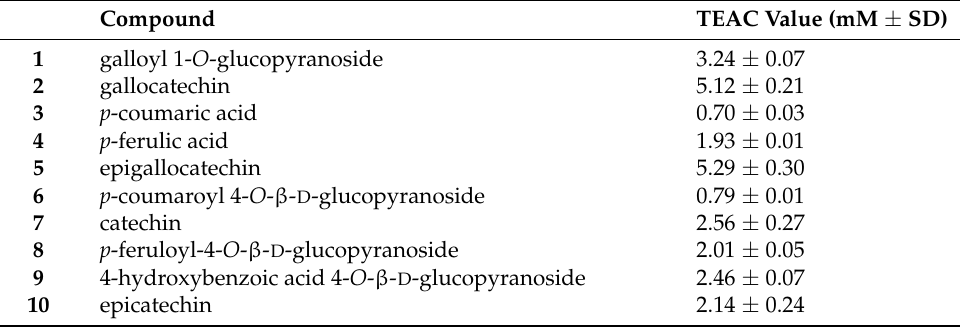
Table 3. ABTS • + radical scavenging activity of isolated compounds 1 – 20